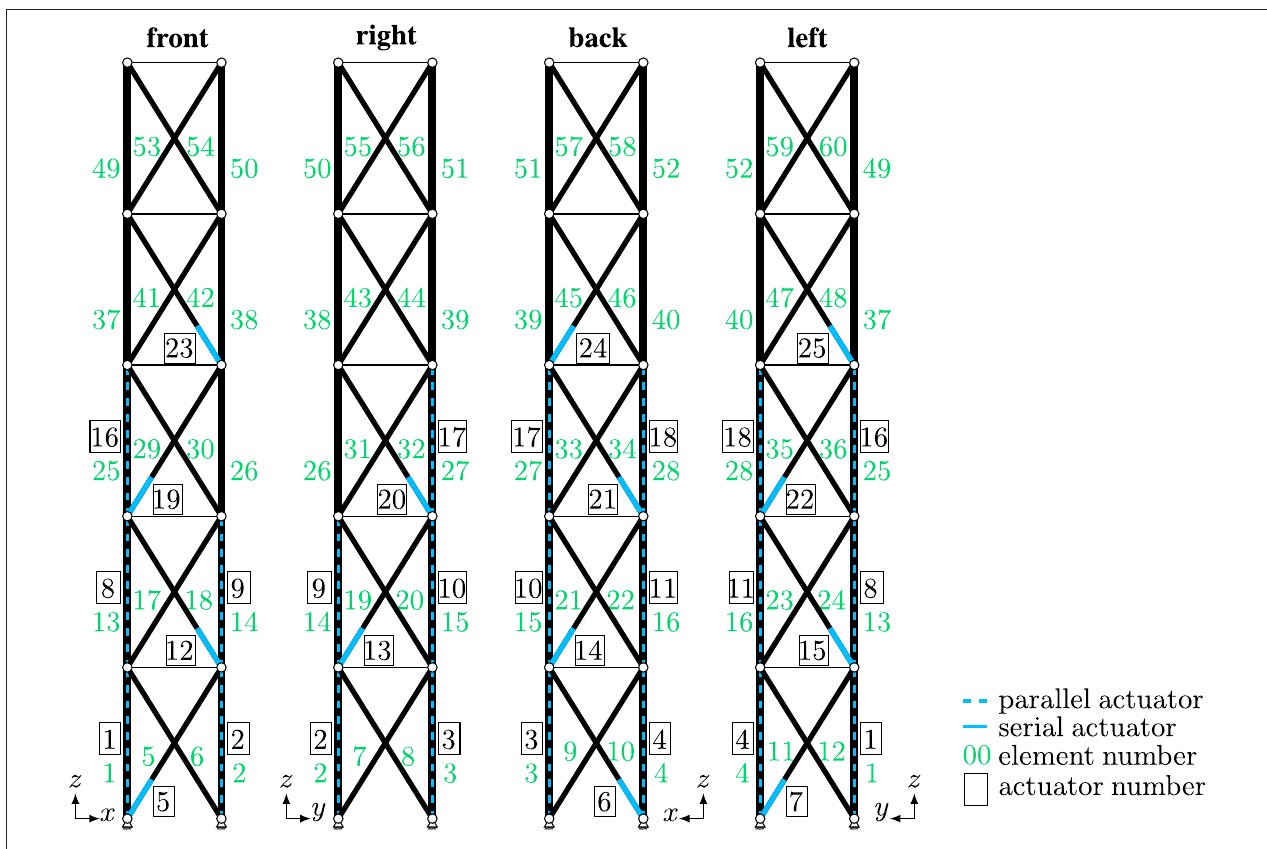
FIGURE 3 | Actuated elements with numbering of the